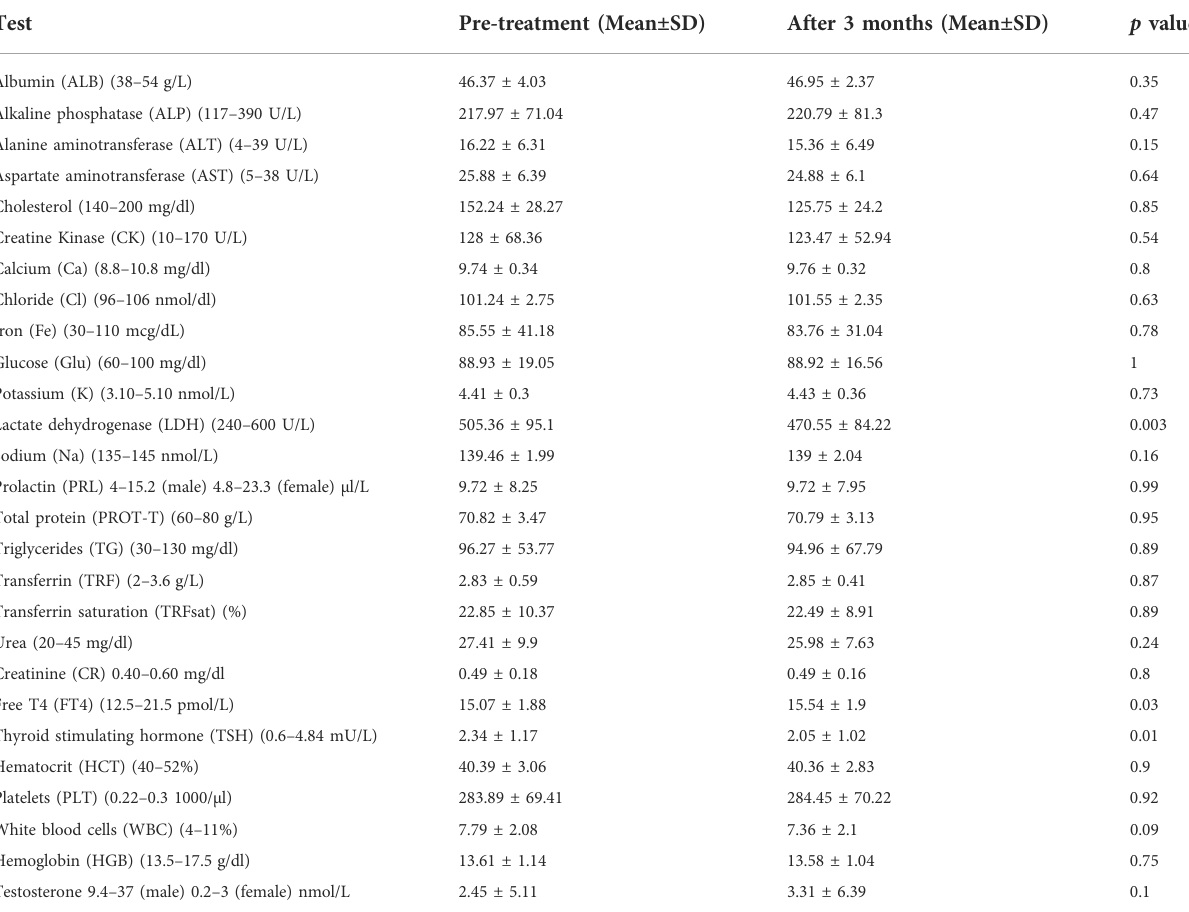
TABLE 2 Blood analysis.